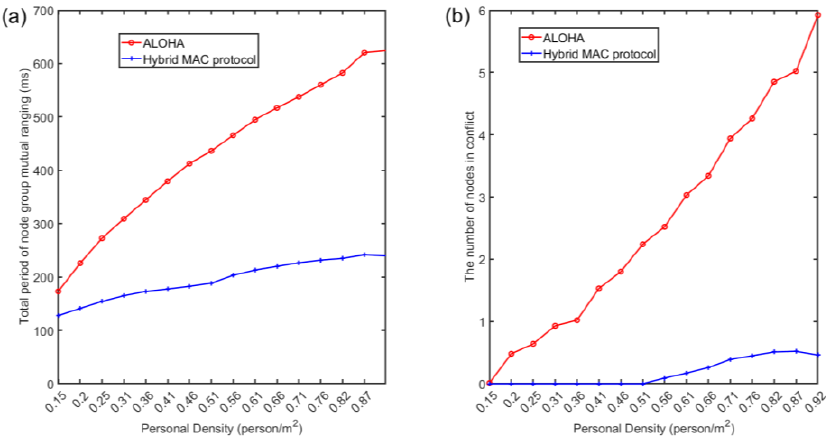
Figure 31. ( a ) The total period of mutual ranging and ( b ) the conflict situation of different channel access methods.